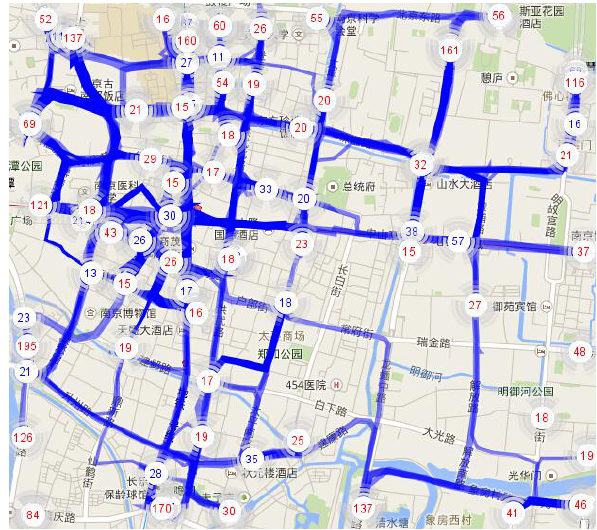
Figure 8. Clustered trajectories based on hot